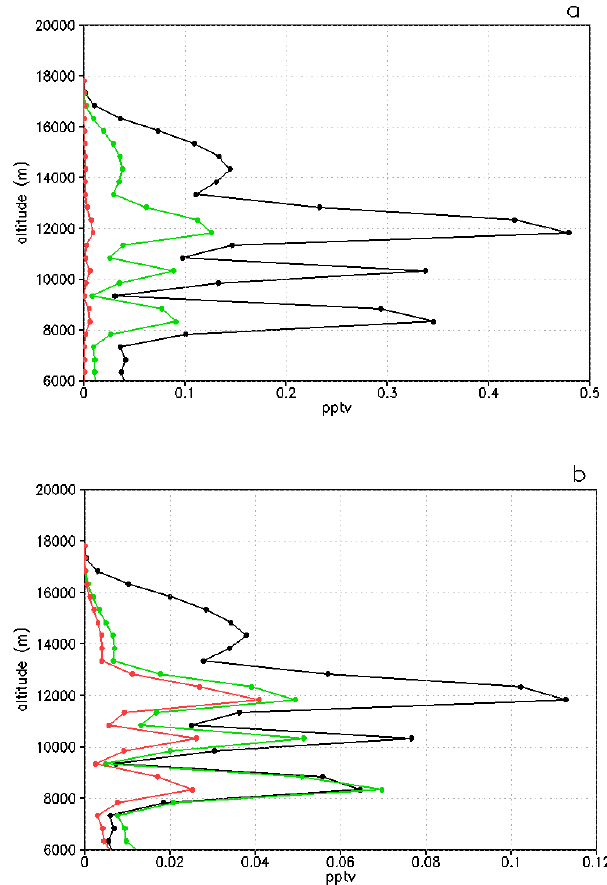
Fig. 12. Mean profiles in the altitude range 6–20km at the end of the convective event ( t 0 + 110min) in the PERT1 simulation of (a) Br- Figure 12: Mean profiles in the altitude range 6 – 20 km at the end of the convective event WMR for the organic species, CBr 2 O (black), CHBrO (green) and (t 0 +110 min) in the PERT1 simulation of a) BrWMR for the organic species, CBr 2 O (black), CHBr 2 OOH+CBr 3 OOH (red) averaged on the horizontal (b) same for inorganic PGs, Br+BrO (black), HOBr (green) and HBr (red) CHBrO (green) and CHBr 2 OOH + CBr 3 OOH (red) averaged on the horizontal b) same for for cloud pH = inorganic PGs, Br+ BrO (black), HOBr (green) and HBr (red) for cloud pH = 5.